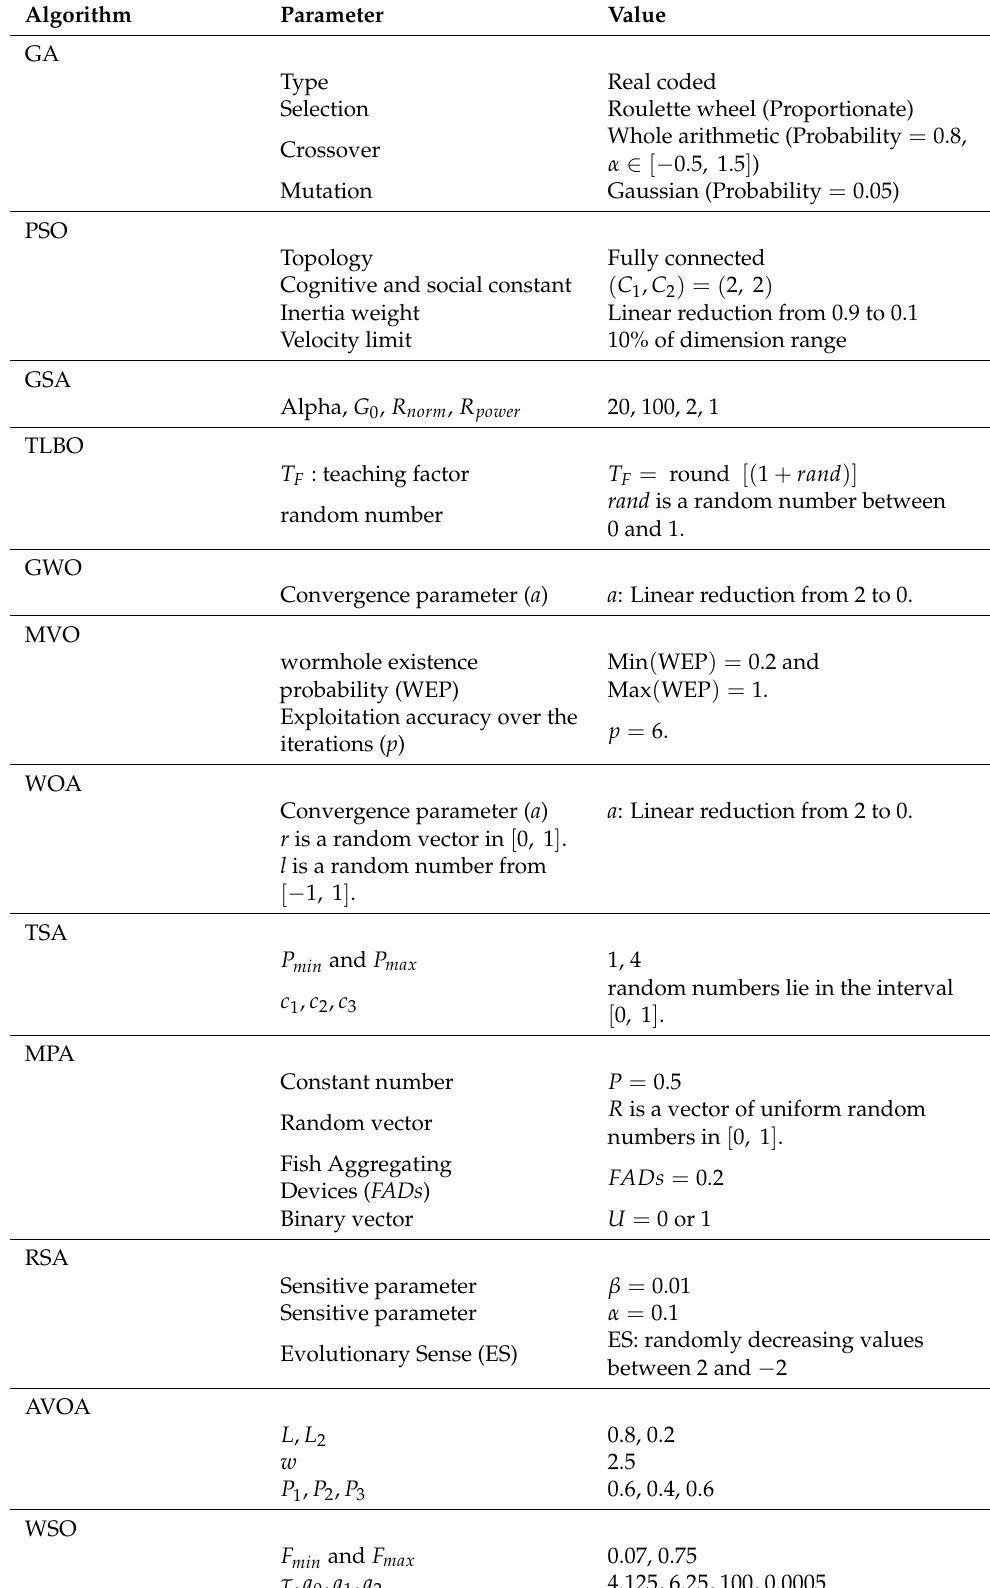
Table 1. Control parameters